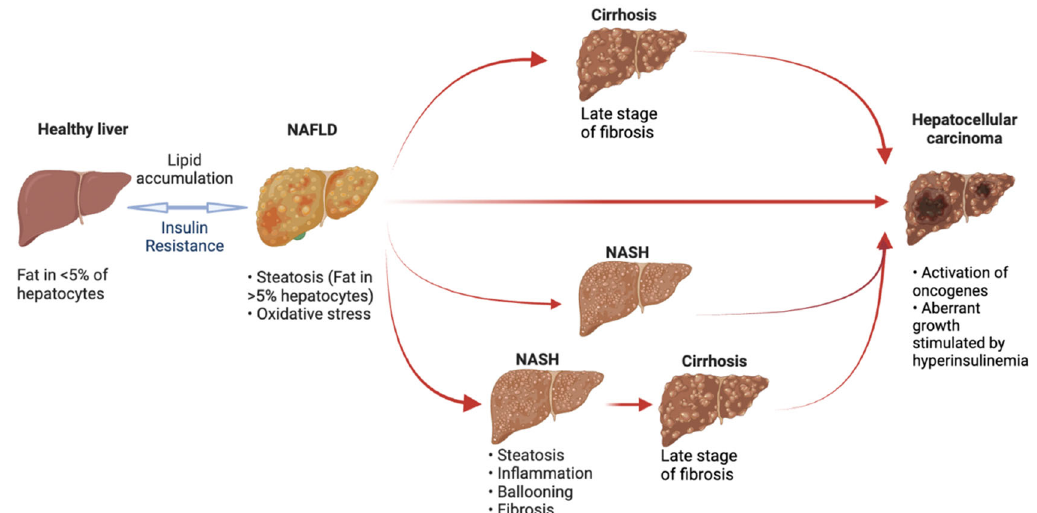
Figure 1. NAFLD development and progression. NAFLD develops from a healthy liver when lipid accumulates in the context of insulin resistance. NASH represents the most aggressive component of the spectrum and is associated with hepatocellular injury and hepatic inflammation. In NAFLD patients, fibrosis may develop in a variable degree up to cirrhosis, while HCC can develop in both cirrhotic and non-cirrhotic patients. (HCC: hepatocellular carcinoma; NAFLD: non-alcoholic fatty liver disease; NASH: non-alcoholic Steatohepatitis).